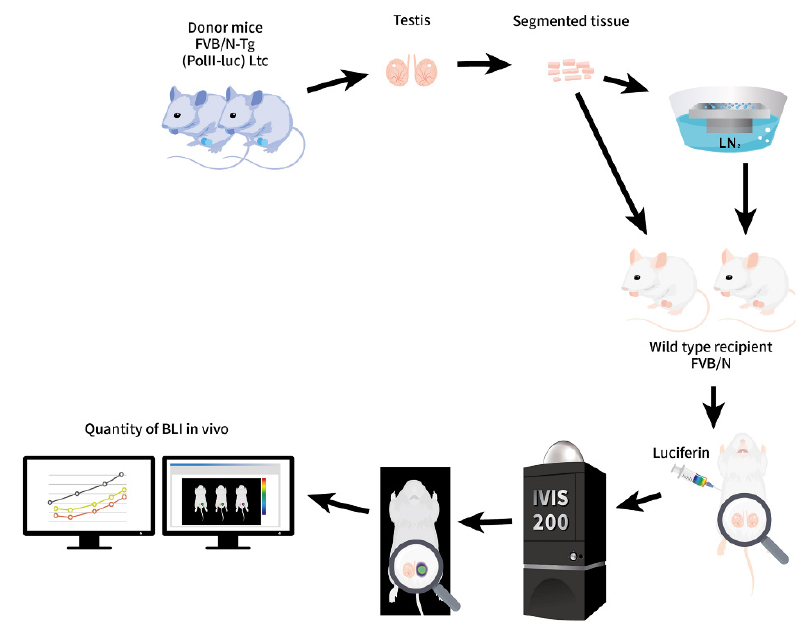
Figure 1. Schematic diagram of the study design. Isolated ITT from the FVB/N-Tg ( PolII-luc ) Ltc transgenic donor mice. Fragmented ITT were processed by SSV over LN 2 , followed by rewarming and iso-graft onto the scrotum of wild-type recipient mice that had undergone orchiectomy. For BLI, luciferin was injected before observing with an IVIS system. The amount of photon yield was proportional to the number of active live cells and tissues in vivo by digital data on a qualitative and quantitative basis. The BLI was tracked from 3-week-old until adulthood.